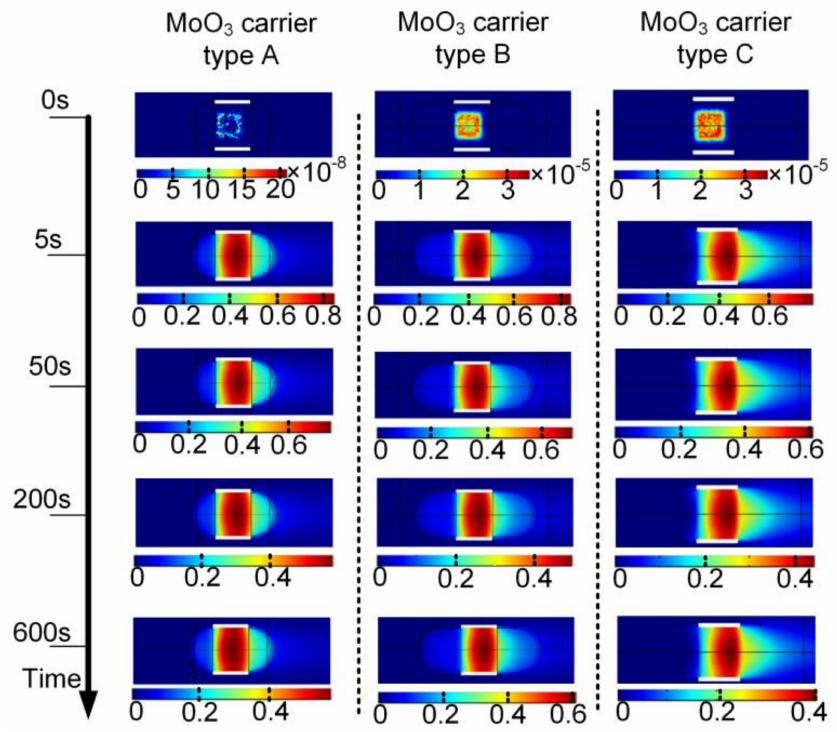
Figure 5. Molybdenum vapor concentration near target surface under different conditions (in mol/m 3